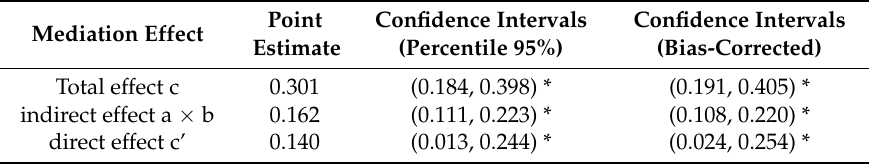
Table 7. Results of testing mediation effects of base